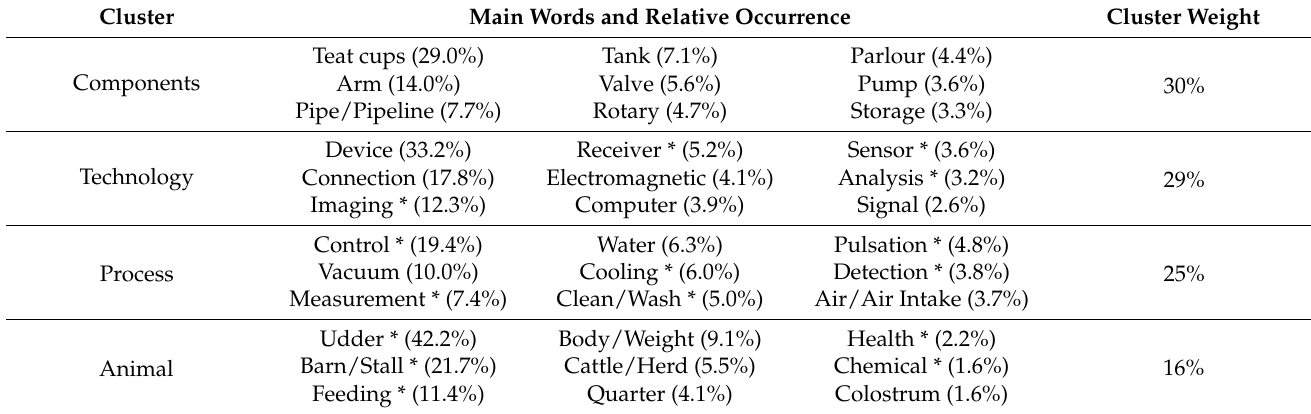
Table 4. Conceptual clusters derived from the analysis of patents. The main words of each cluster, along with their frequency, is reported in the second column. Words marked with an asterisk have undergone the stemming process, which consists of including in a single lemma all variant forms of the same word (i.e., images and imaging, or udder and teats). In most cases stemming was applied to words with common root (e.g., analysis and analyse); in some cases, stemming was applied to words with the same meaning (e.g., udder and teat).